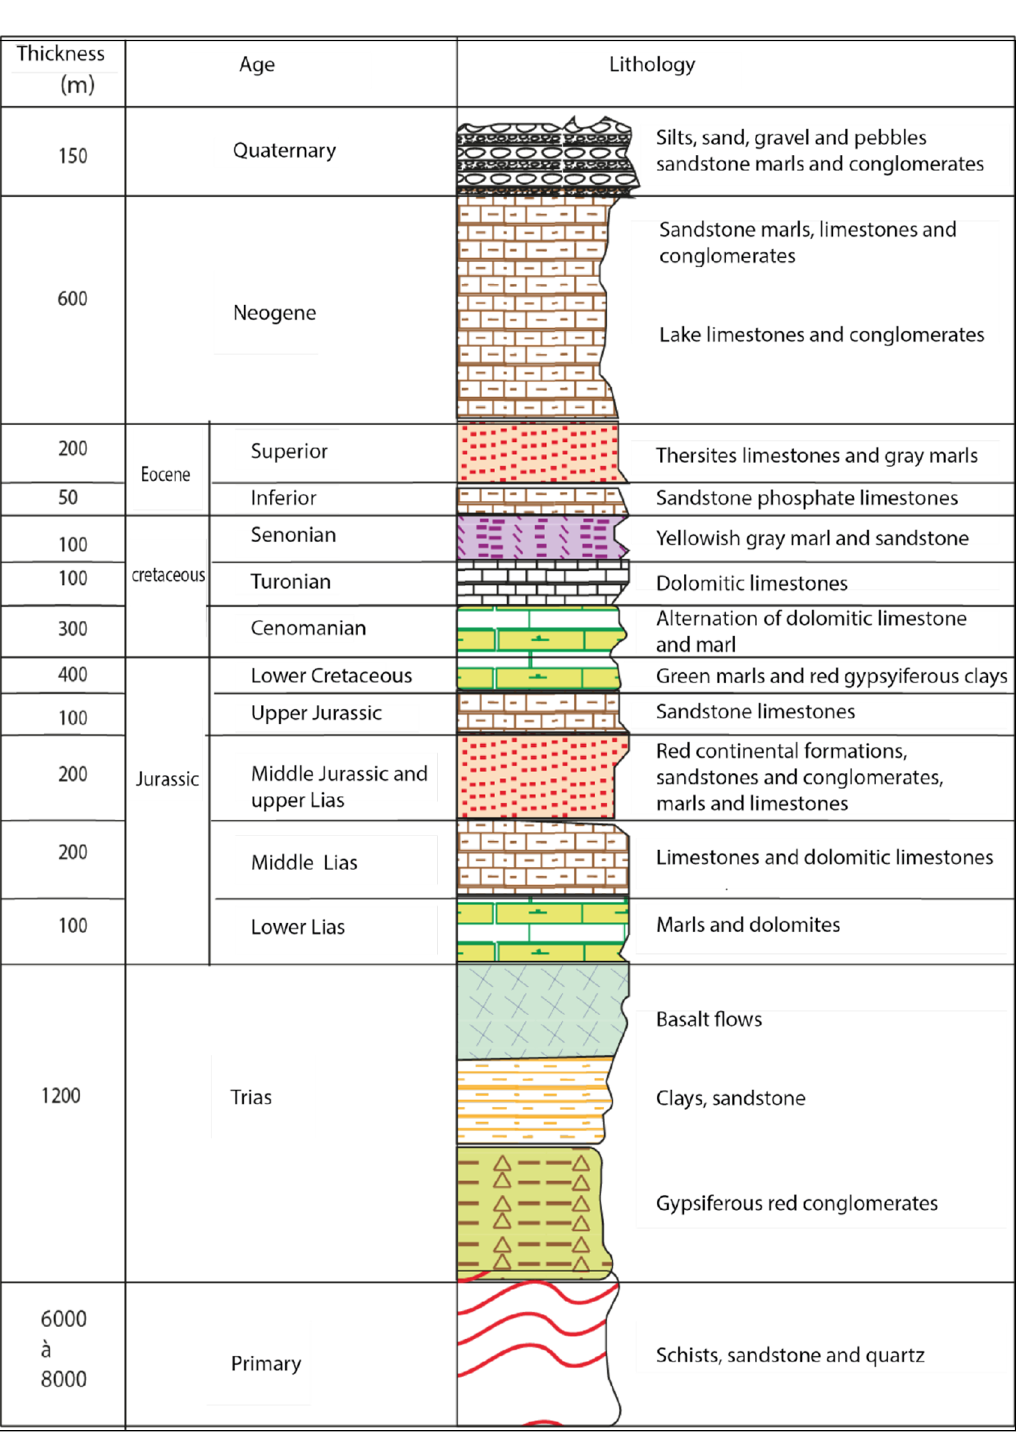
Figure 2. Litho-stratigraphy of western Haouz plain [59].